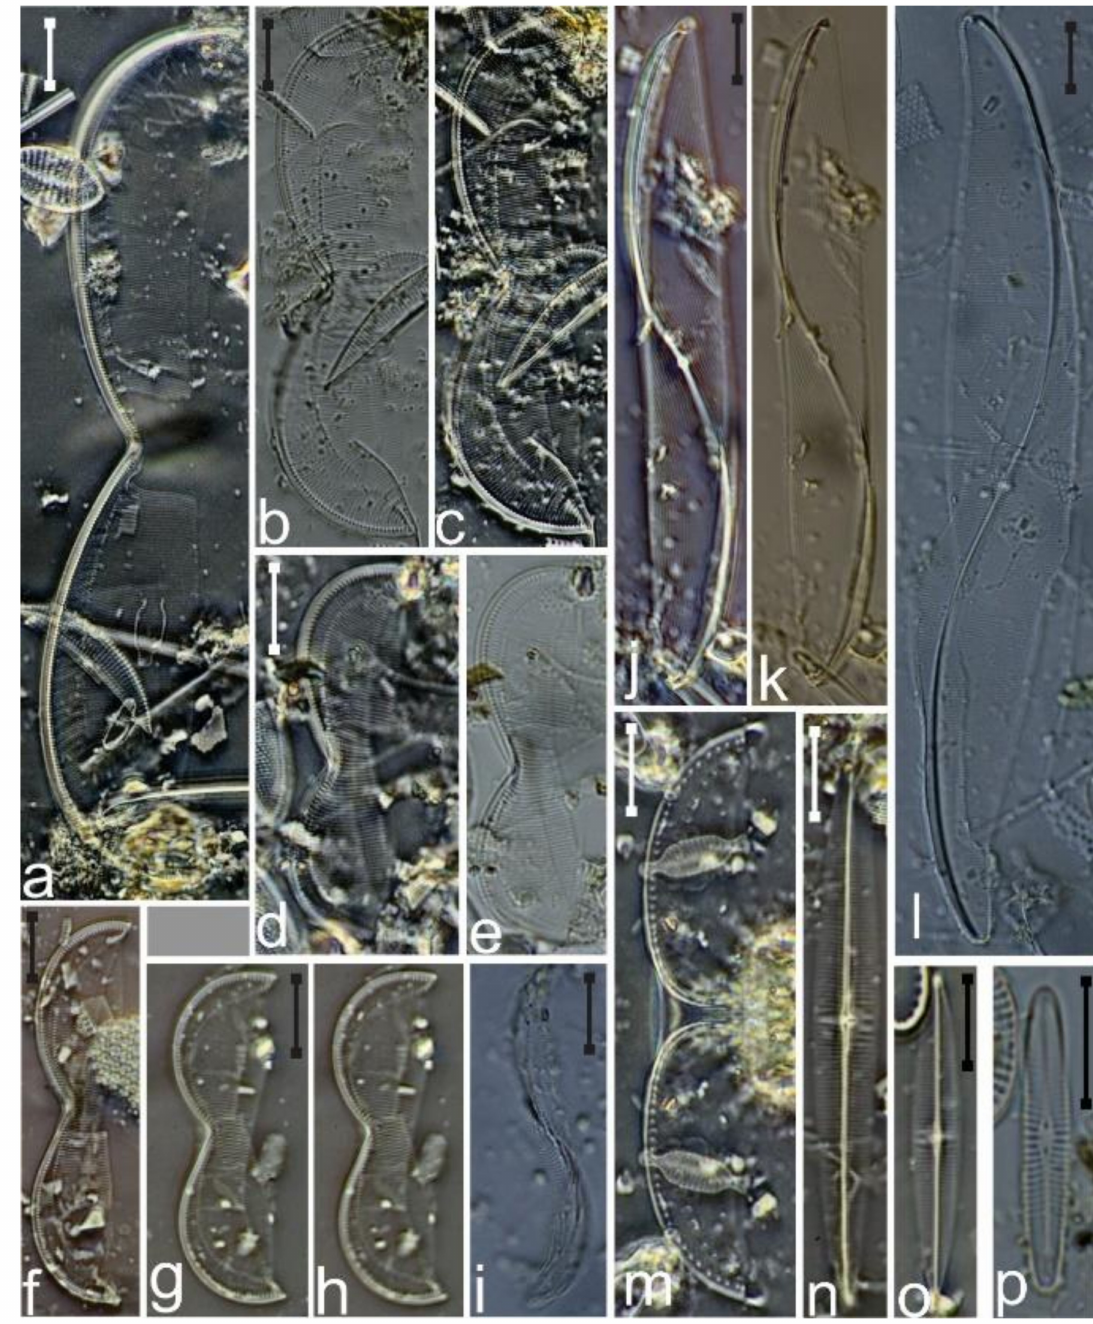
Figure 38. ( a – i ) Entomoneis paludosa ; ( j – l ) Donkinia carinata ; ( m ) Thalassiophysa hyalina ; ( n , o ) Proschkinia complanata ; ( p ) Rhoicosphenia abbreviata . Scale bar = 10 µ